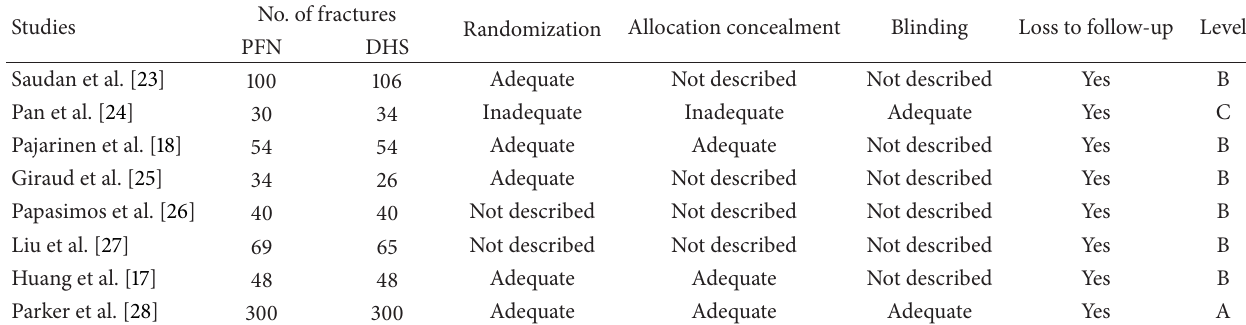
Table 2: Methodological quality of included studies.